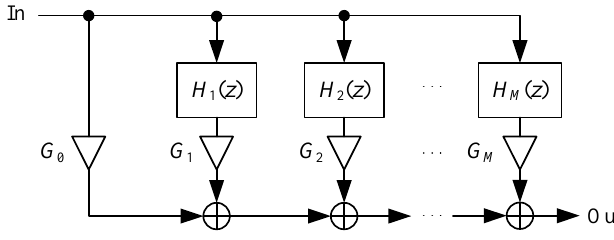
Figure 10. Parallel implementation of a graphic equalizer in which all bandpass filters receive the same input signal. The output is obtained as a sum of individual filter outputs weighted by command